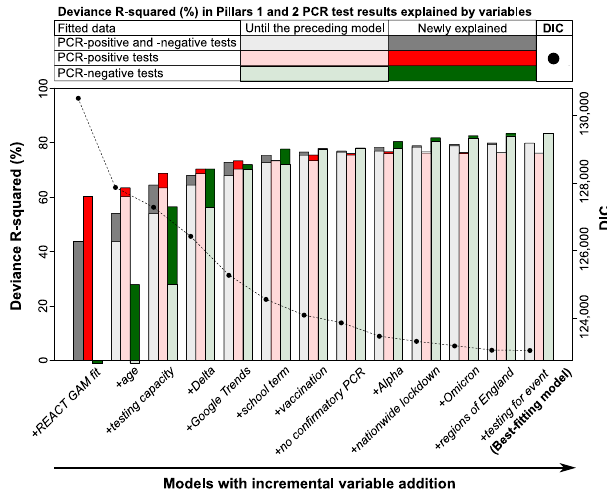
Fig. 3 | Deviance R-squared (%) explained during a forward stepwise selection procedure. Variables were added incrementally to the baseline model with only REACTGAM fi t(mostleft)untilthebest- fi ttingmodel(mostright).Foreachmodel, bars represent the total deviance R-squared explained by variables added in the preceding steps and the newly added variable (left y -axis). Different bar colours represent the deviance R-squared for PCR-positive tests (red), PCR-negative tests (green), or both (grey), with darker portions representing the deviance R-squared additionally explained by the newly added variable. Points represent the deviance information criterion (DIC) of each model (right y -axis).